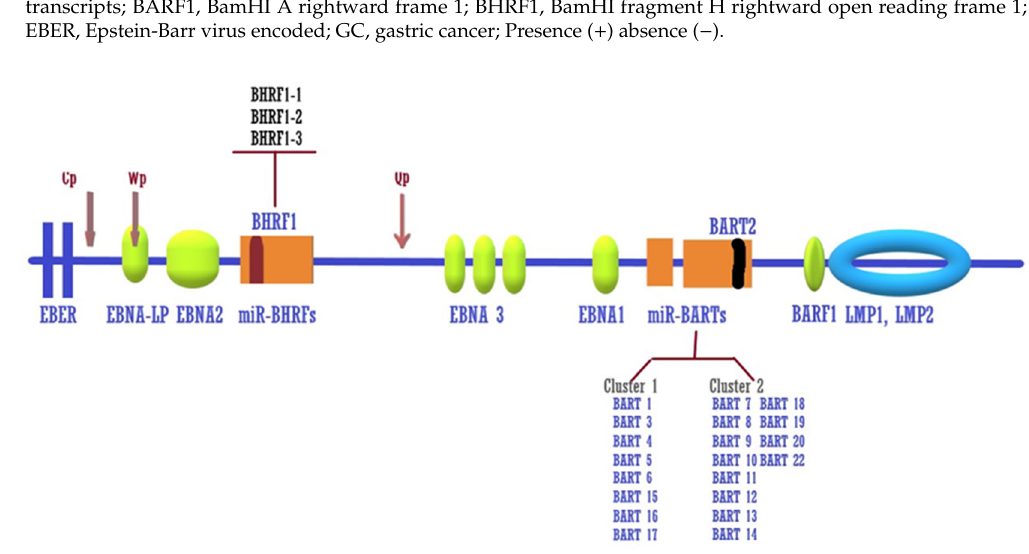
Figure 1. Structure of the EBV genome. Latent proteins (Epstein–Barr virus nuclear antigen (EBNA)1, EBNA2, EBNA3, EBNA-leader protein (LP), BamH1 A reading frame-1 (BARF1), latent membrane protein (LMP) 1 and LMP2 and non-coding RNAs (Epstein–Barr-encoded RNAs (EBERs). miRNAs distributed in three clusters: Bam HI fragment H rightward open reading frame 1 (BHRF1) cluster, BamHI A rightward transcript (BART) cluster 1, and BART cluster 2. Besides, a single miRNA, miR-BART2, is encoded by a region outside the BART cluster. BHRF1 is a homolog to the human Bcl-2 and delays cell death during the EBV lytic cycle replication. miR-BART2-5pencodes antisense to EBV DNA polymerase catalytic subunit BALF5, thus inhibiting the transition of latent to lytic cycle [18]. miR-BART of clusters 1 and 2 are abundantly expressed in latency [19]. EBV EBNA gene transcription during viral latency is regulated by the EBV latency promoters, Cp, Wp, and Qp. Cp and Wp are the origins of the long primary transcript including all the six EBNAs (latency III). In GC cells, Cp and Wp are silenced and only EBNA1 is produced that initiate at the Qp promoter. The latent promoter positions are indicated by arrows.